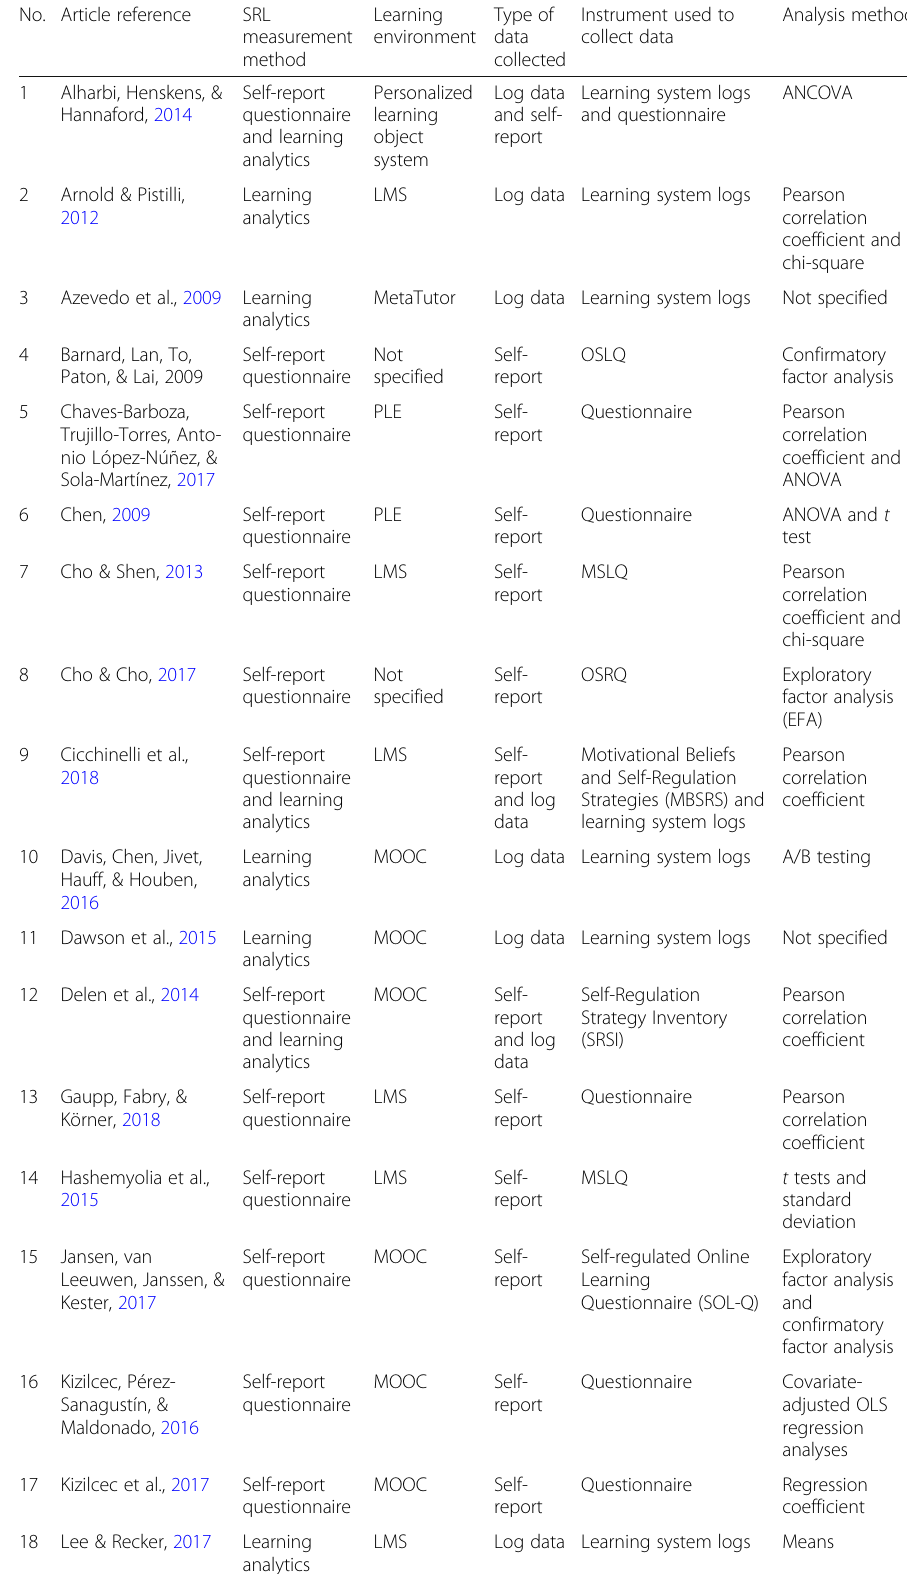
Table 1 Summary of the reviewed studies No. Article